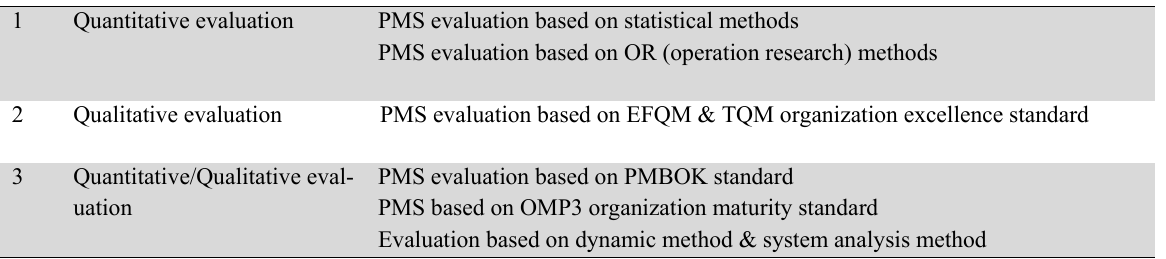
Different methods of PMS